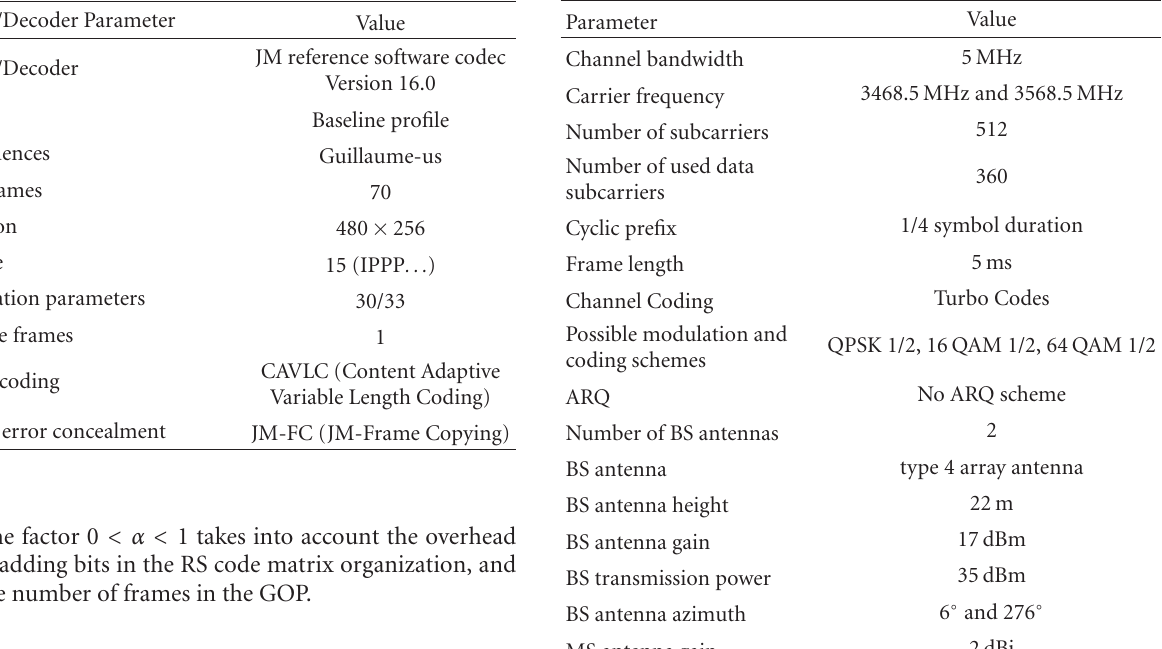
Table 2: Video coding simulation parameters. Table 3: WiMAX RAN system parameters.